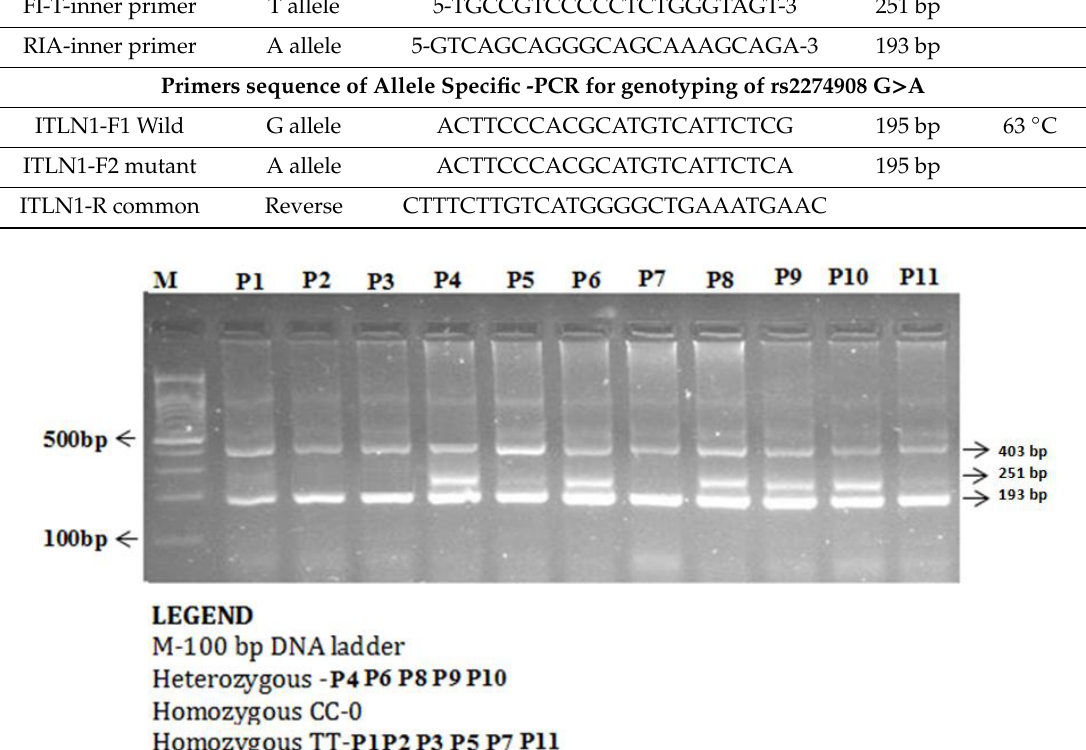
Figure 2. Detection of Omentin-1 rs2274907 A>T gene variation with amplification refractory mutation system (ARMS-PCR) in coronary artery disease (CAD) cases.